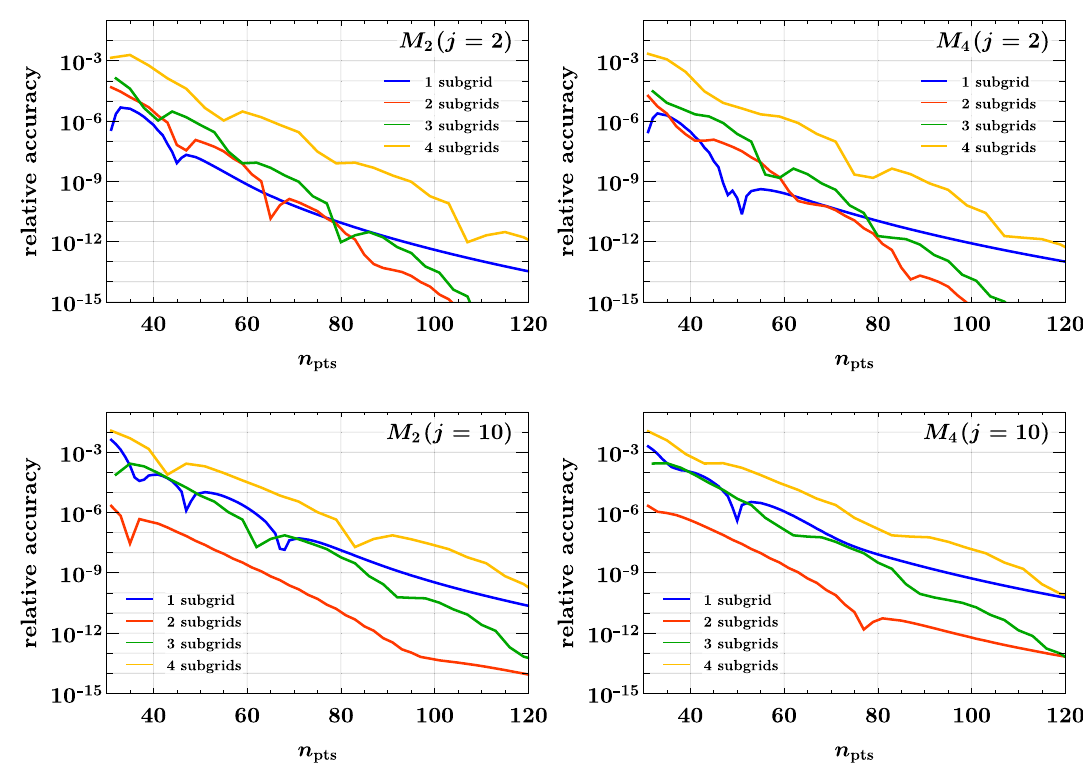
Fig. 6 Relative accuracy of the truncated Mellin moments (40) with x 0 = 10 − 9 and with j = 2 (top) or j = 10 (bottom), for f 2 ( x ) (left) or f 4 ( x ) (right). We use Chebyshev grids with k = 1 to 4 subgrids